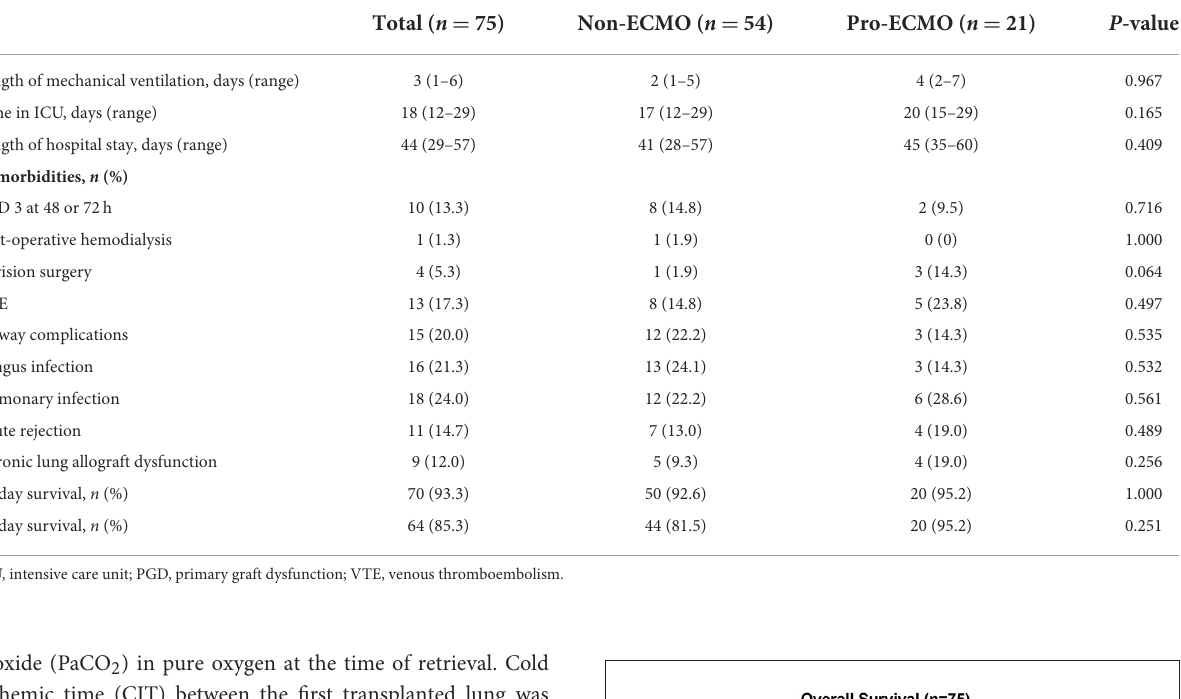
TABLE 2 Perioperative outcomes.